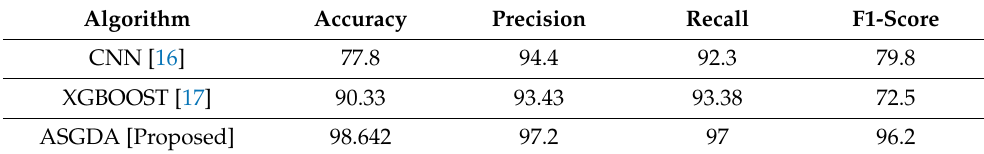
Table 1. Comparison of traditional methods with the proposed method.